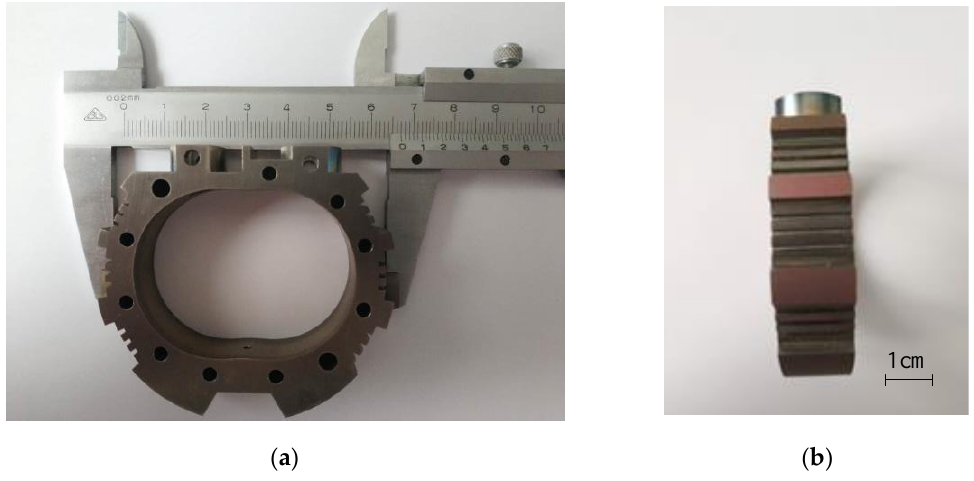
Figure 15. Cylinder with microtextures in ( a ) front view and ( b ) left view.